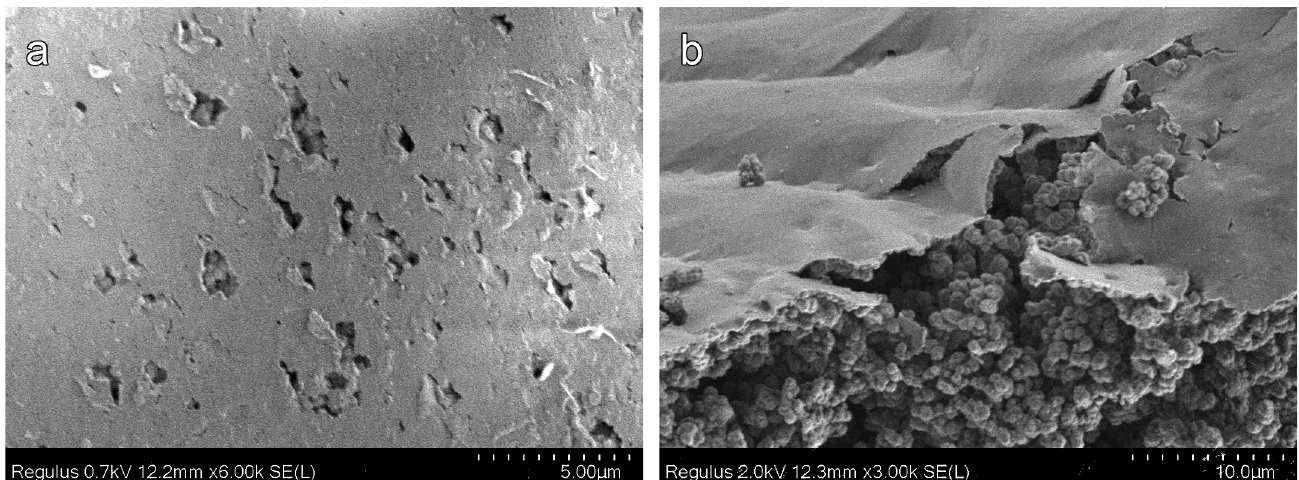
Figure 7. The pore size distribution of poly-OCM-2 (M12-M14) obtained from OCM-2 in the presence of 1-butanol (50–70 wt %).